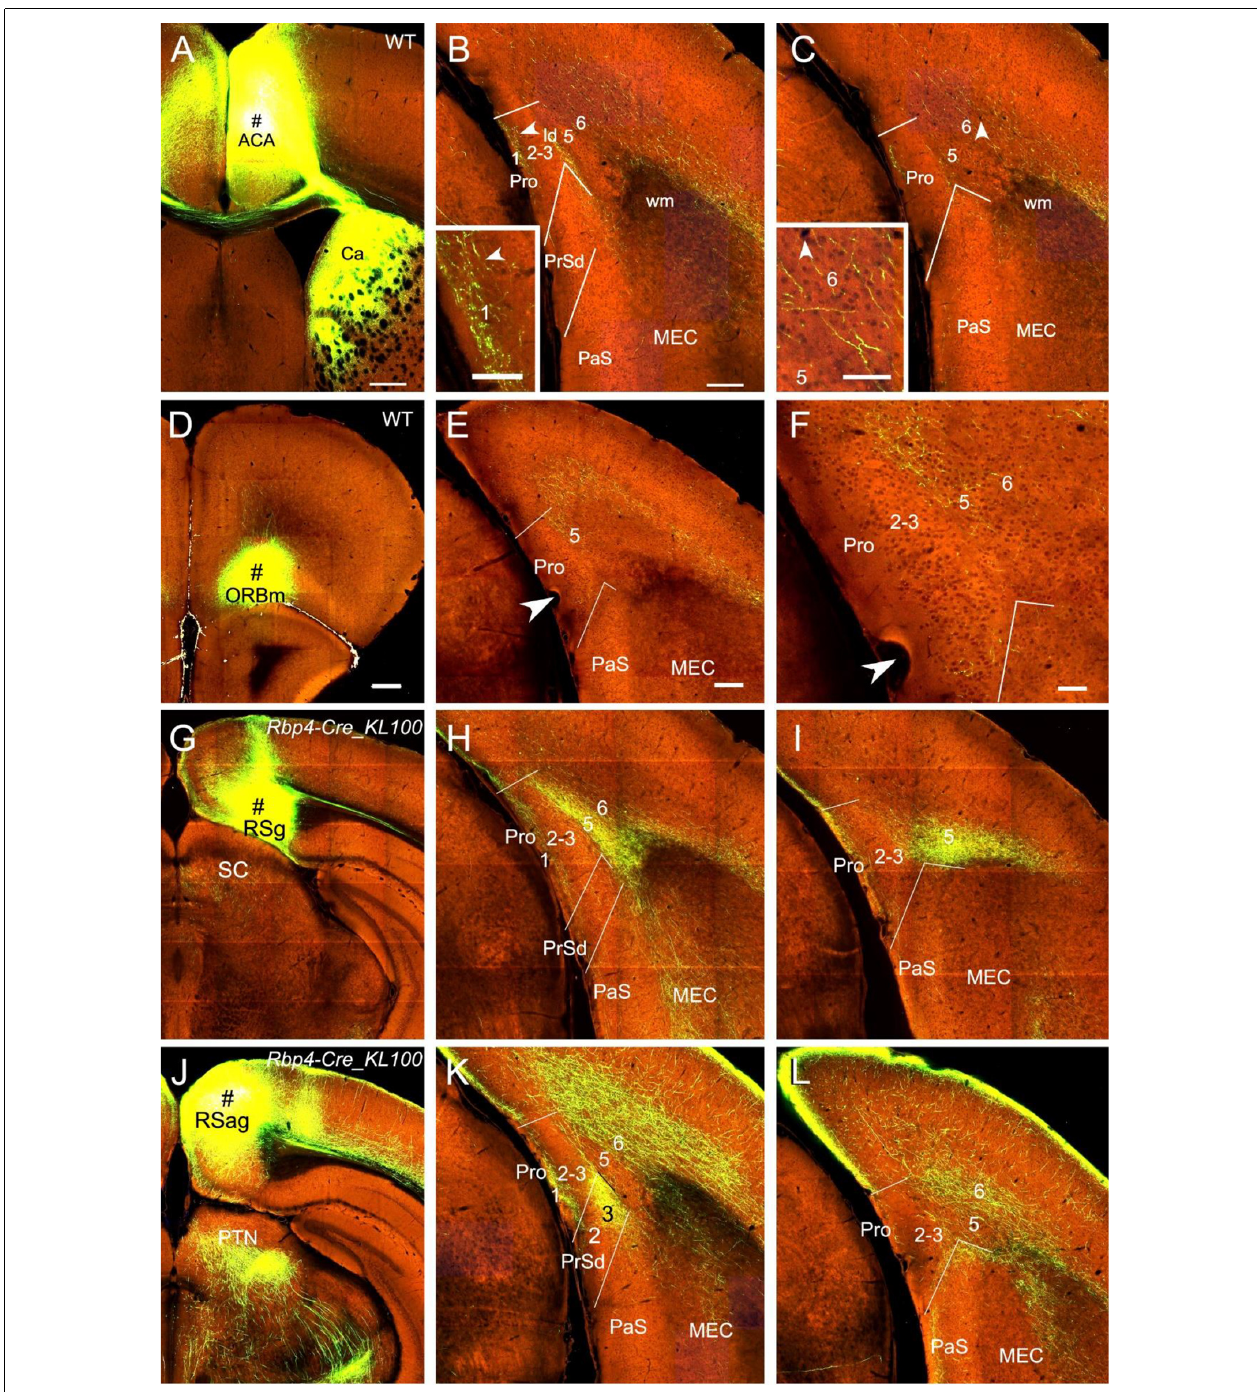
FIGURE 7 | Projections from frontal and retrosplenial cortices to the Pro. (A–C) . An injection in the medial frontal cortex (i.e., anterior cingulate area, ACA; # in A ) of WT mouse produces moderate and weak terminal labeling in L1 and L6 of the Pro, respectively (B,C) . Lamina dissecans (ld) also contains moderate labeling. The labeling in L1 and L6 of the Pro is magnified in the insets in (B) and (C) , respectively. Note the very strong terminal labeling in the dorsal caudate (Ca in A ). (D–F) An injection in the medial orbitofrontal cortex (ORBm, i.e., Brodmann area 11; # in D ) of a WT mouse gives rise to moderate terminal labeling in L5 of the Pro (E,F) . The Pro labeling in (E) is magnified in (F) . (G–I) An injection in RSg (# in G ) of a Rbp4 -Cre_KL100 mouse (Cre expression in L5) results in moderate and strong terminal labeling in L1 and L5 of the Pro, respectively (H,I) . (J–L) An injection in RSag (# in J ) of a Rbp4 -Cre_KL100 mouse leads to moderate and strong terminal labeling in L1 and L6 of the Pro, respectively (K,L) . Note that RSag but not RSg projects heavily to L3 of the PrSd (K) . Arrowheads in low- and high-magnification images of the Pro point to corresponding locations. Bars: 350 µ m in (A) ; 200 µ m in (B) (also for C ); 70 µ m in the insets in (B) and (C) ; 350 µ m in (D) (for D , G , and J ); 200 µ m in (E) (for other